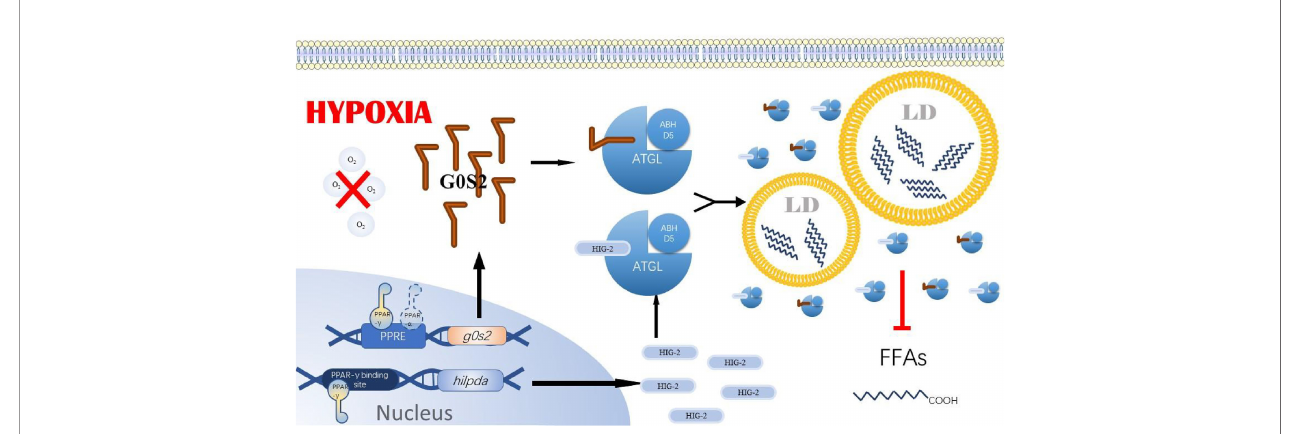
FIGURE 3 | PPAR-y/G0$2/ATGL axis. In tumor cells under hypoxia, PPAR-g g in cells binds to the PPRE region upstream of g0s2 and hilpda, promoting the expression of GOS2 and HI G-2. PPA R- a also binds to the PPRE region upstream of gOS2, promoting the expression of GOS2. gOS2 contains a similar segment of HD as HIG-2 and is also able to bind ATGL, inhibiting ATGL anchoring to the LD membrane and its activity. Ultimately, the overexpression of GOS2 and HIG-2 in tumor cells prevents ATGL from performing its typical hydrolytic role, leading to the accumulation of lipid droplets. PPAR- a : peroxisome proliferator-activated receptor a, PPA R- g : peroxisome proliferator-activated receptory g , GOS2, GO/G1 switch gene 2; PPRE, PPAR response element; ATGL, Adipose triglyceride lipase; ABHDS, I acylglycerol – 3 – phosphate O acyltransferase; LD, Lipids droplet; FFAs, Free fatty